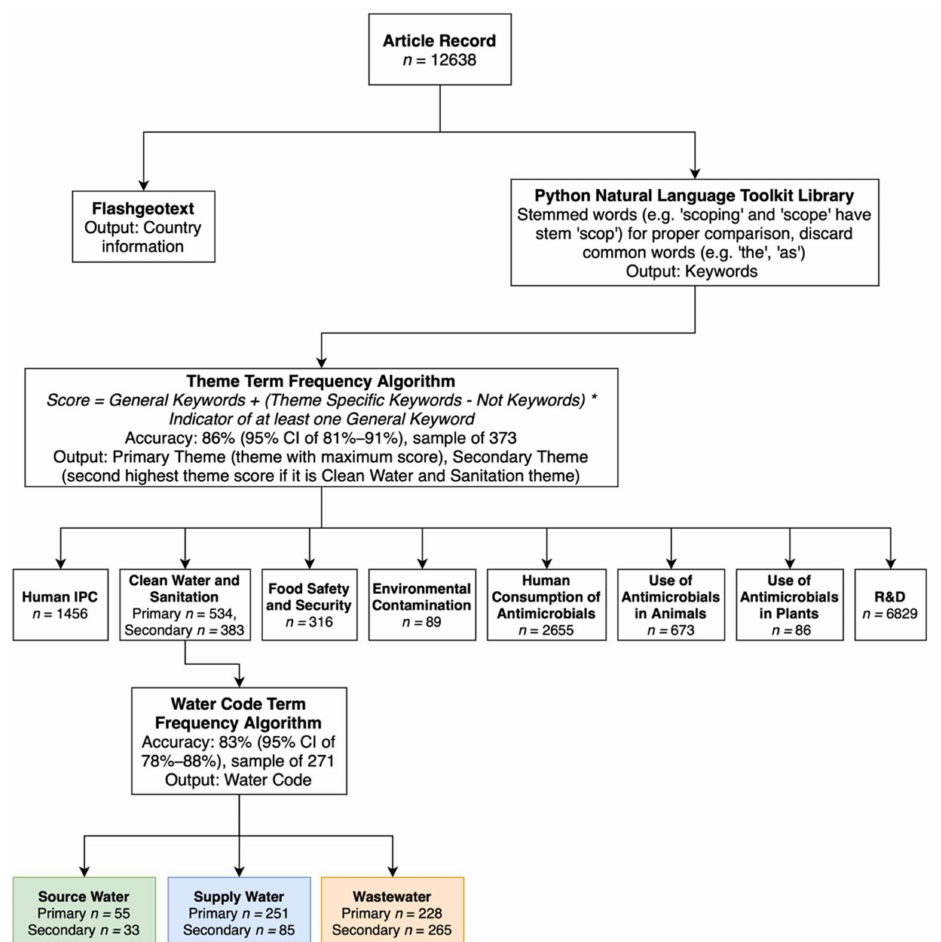
Figure 2. Overview of the data mining and categorization of AMR article records used in this study by geographic information, AMR themes (primary and secondary: clean water and sanitation only) and water types. The classification algorithm’s accuracy for each classification is listed along with the simple random sample used to